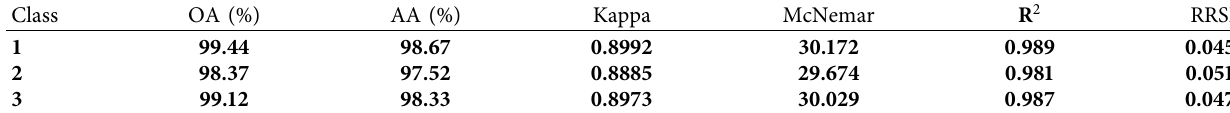
Table 1: The outcomes of the